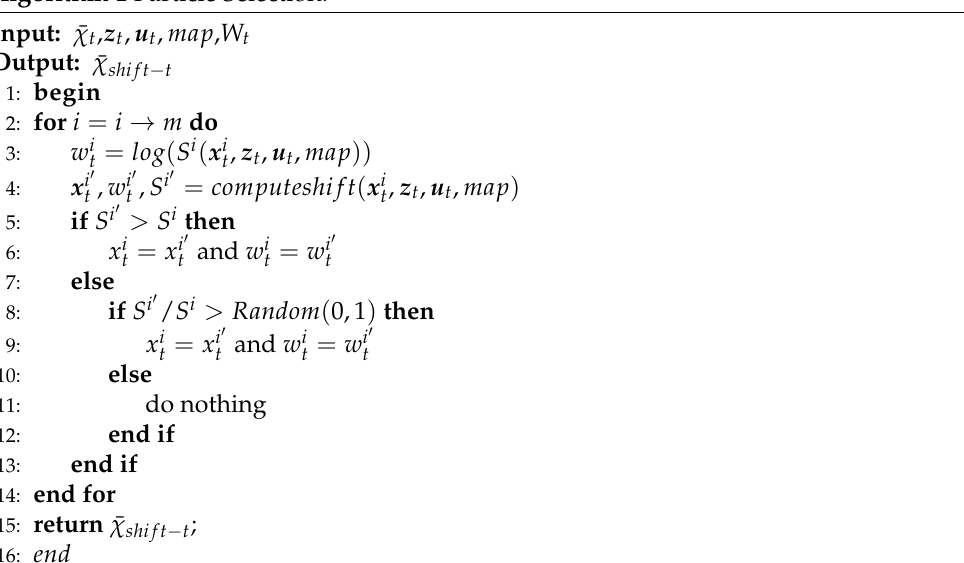
Algorithm 1 Particle